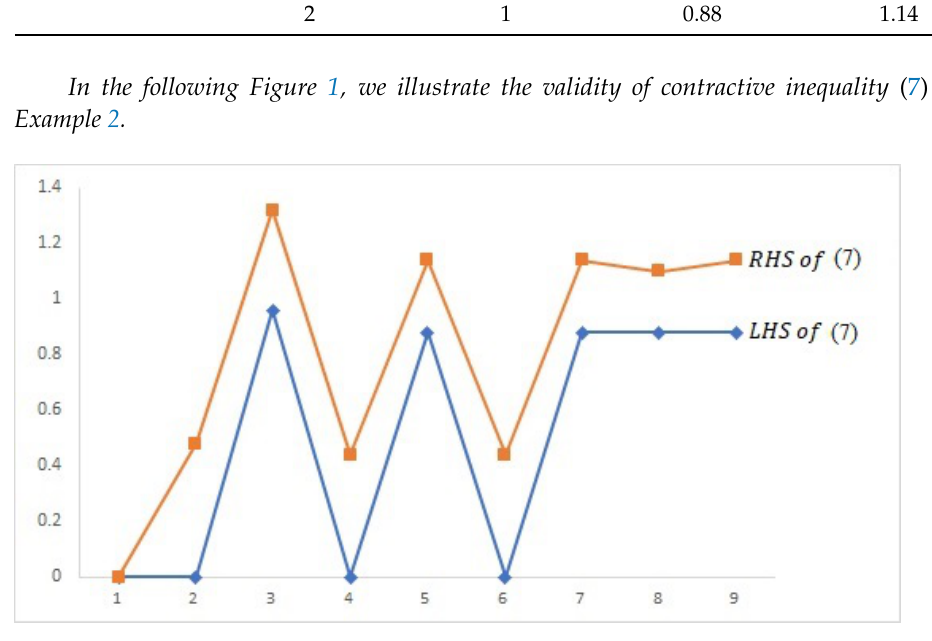
Figure 1. Illustration of contractive inequality (7) using Example